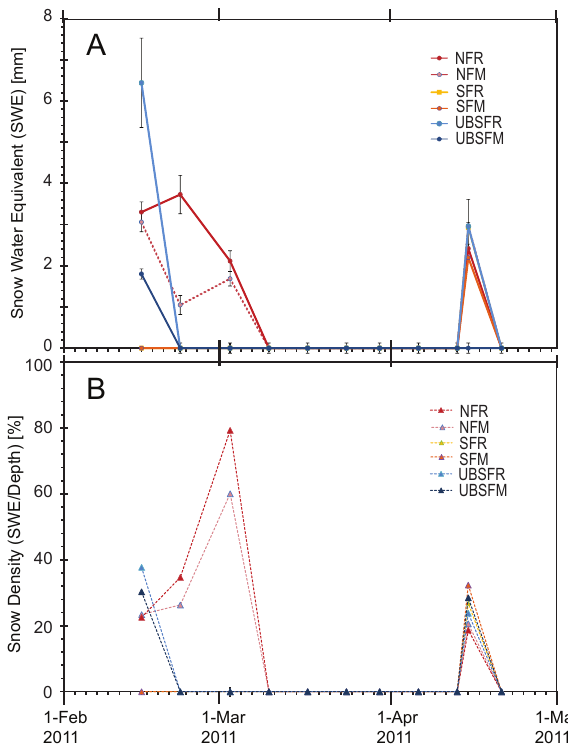
Fig. 4. Time series of snow measurements at the Fourmile Canyon Fire site. (A) Snow-water equivalent (SWE). (B) Snow density (SWE/snow